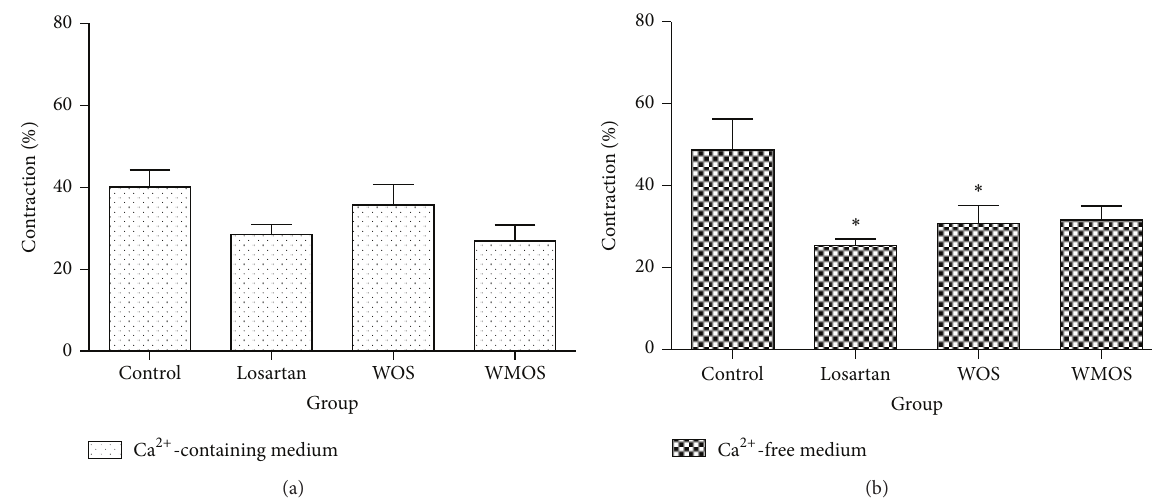
in WMOS, enhancement of vasorelaxation might be due to the fact that vasodilator PGI 2 is continuously released as indicated by its tonic effects on platelet cAMP. In addition, WOS inhibited the contraction of aortic rings induced by PE, implying that WOS inhibits the release of intracellular Ca 2+ and/or blocks